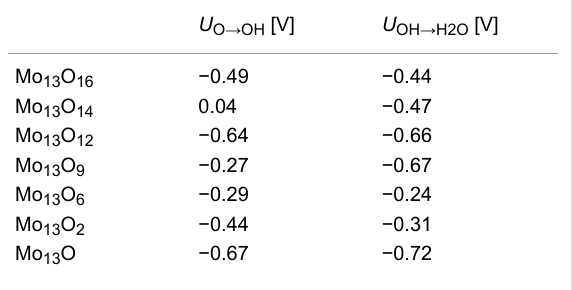
Table 3: Reduction of an oxygen overlayer on molybdenum nanoparti- cles. Multiple adsorbed oxygen atoms have been reduced at the studied oxygen coverage. This is done to probe the reduction of all the unique adsorption sites at the studied oxygen coverage. U O → OH [V] U OH → H2O